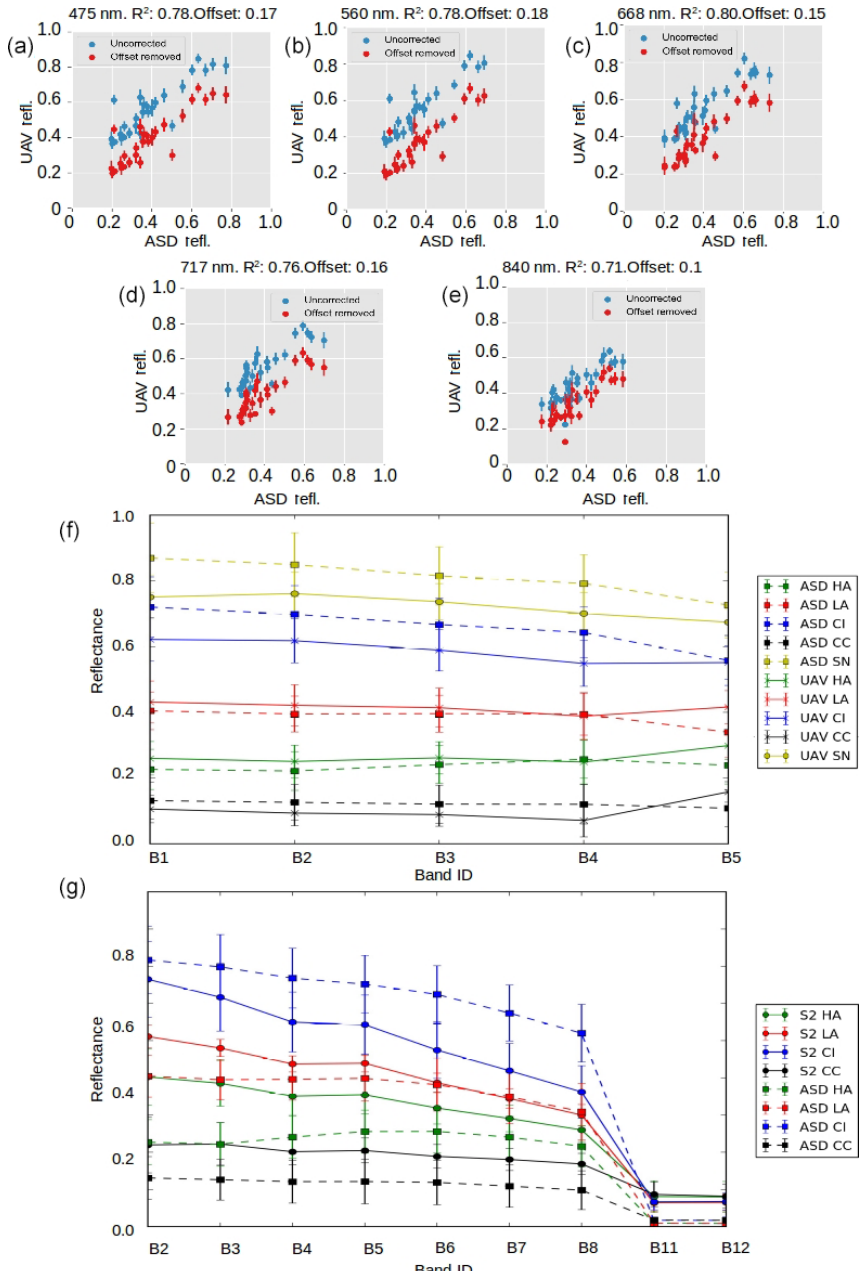
Figure 3. Inter-sensor comparisons. (a–e) Each UAV band reflectance plotted against ASD reflectance in uncorrected (blue) and corrected (red) form. The correction was applied to account for a systematic offset shown in the header for each plot. (f) Mean reflectance and ± 1 standard deviation error bars at each spectral band for each surface class for the ASD field spectrometer and the UAV-mounted multispectral camera. (g) Mean reflectance and ± 1 standard deviation error bars at each spectral band for each surface class for the ASD field spectrometer and